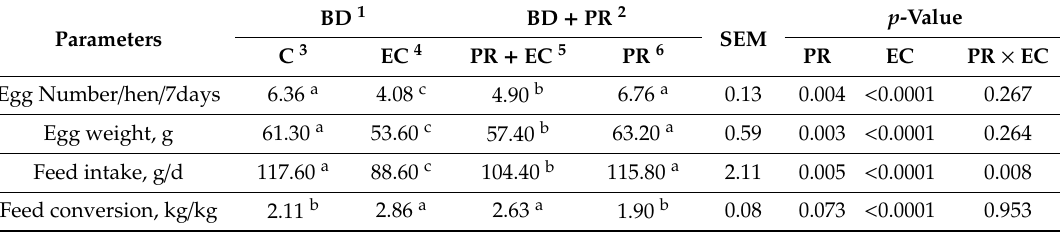
The e ff ects of dietary propolis supplementation and E. coli challenge on layer productive